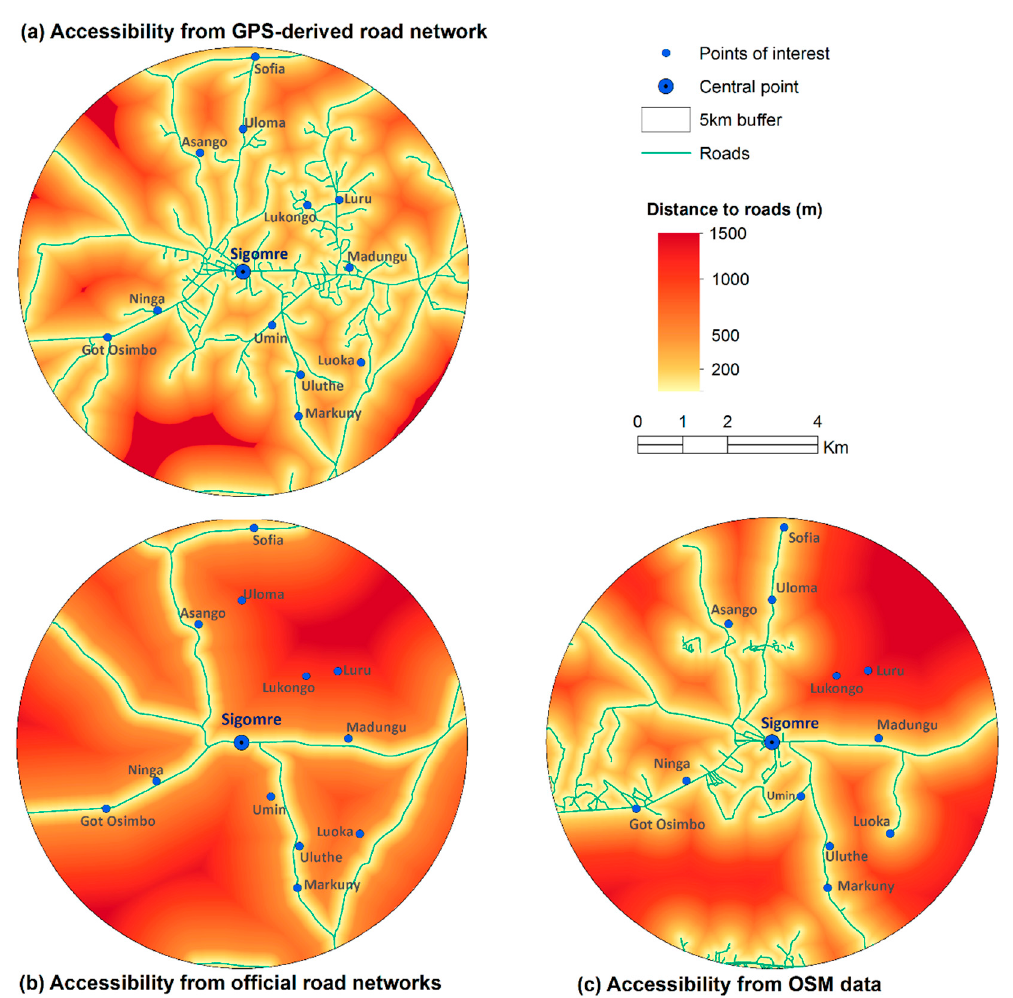
Figure 7. Accessibility surfaces as computed from Euclidean distance from ( a ) GPS-derived road networks ( b ) official road networks and ( c ) Open Street Map road networks.